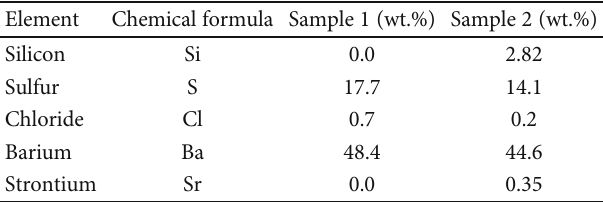
Table 5: The chemical composition of the new scale dissolver. Table 2: XRF results for the collected barium scale samples.